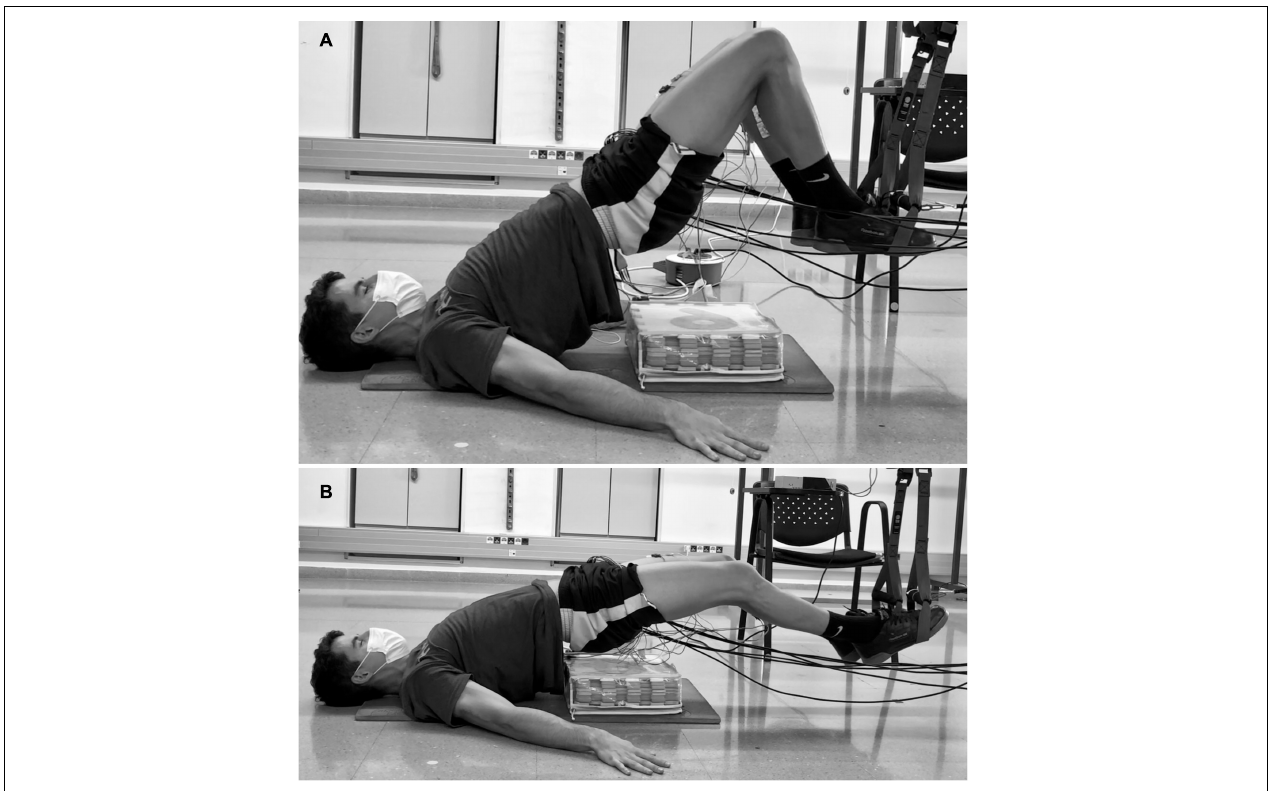
FIGURE 2 | Suspended hamstring curl: upper (A) and lower (B)